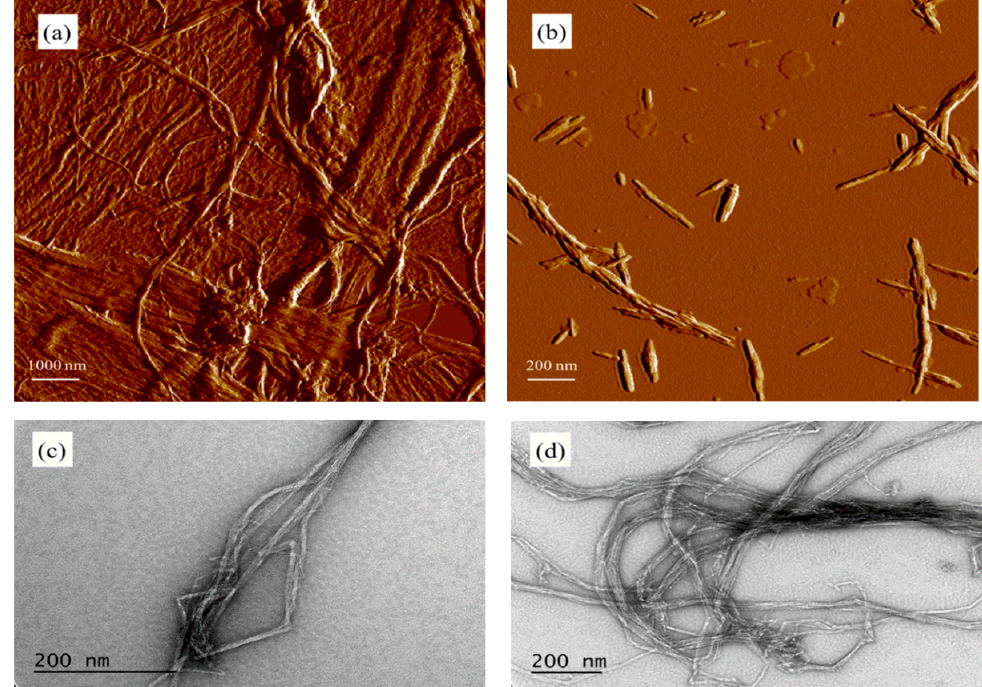
Figure 2. Morphology of CNFs and CNCs, ( a ) and ( b ): Atomic Force Microscopy (AFM) micrographs of CNFs and CNCs; ( c ) and ( d ): TEM micrographs of CNFs with two different regrinding conditions (10 and 30 times), respectively.